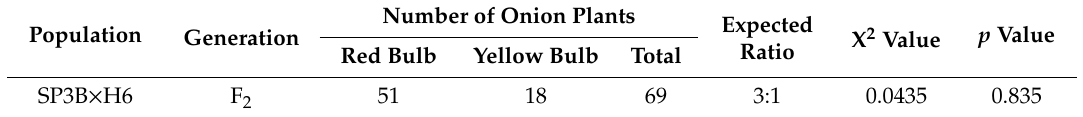
Table 5. Segregation analysis of onion bulb colors in an F 2 population of SP3B×H6.